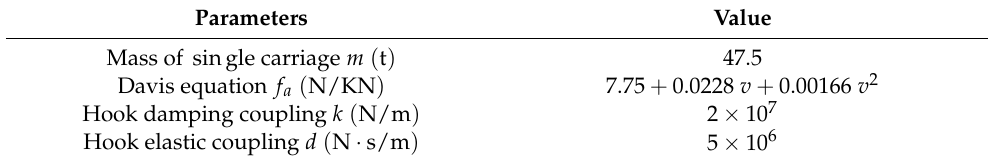
Table 2. Parameters of the HST.